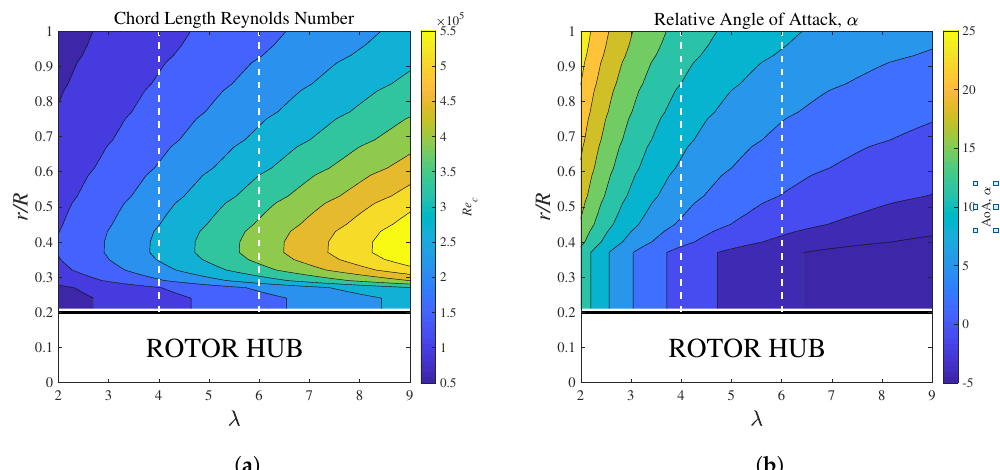
Figure 5. Model of chord length Reynolds number ( a ) and local relative angle-of-attack ( b ) for the RM1 model-scale NACA 4415 blades. Vertical dashed white lines bound the region of measured optimal performance.